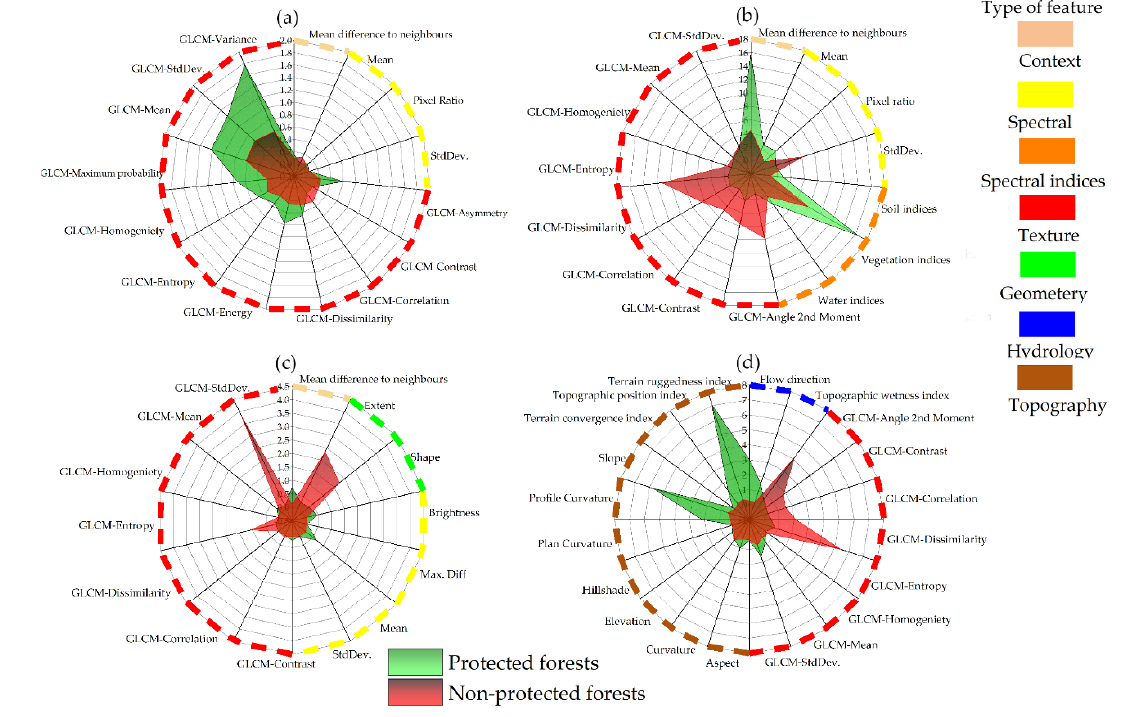
Figure 5. Comparison of the importance of the image-derived features of Sentinel-1A ( a ), Sentinel-2A ( b ), Sentinel-1A and -2A ( c ), as well as the digital elevation model (DEM) ( d ), features for discriminating landslide objects from non-landslide objects in the protected forests (old landslides) and non-protected forests (new landslides) in NE Iran.